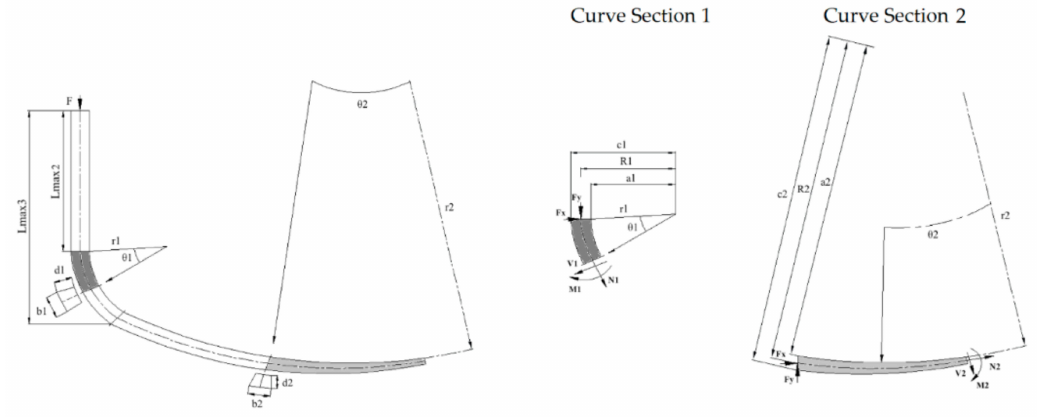
Figure 9. Forces and moments sum. Free body diagram of curved sections of MH under